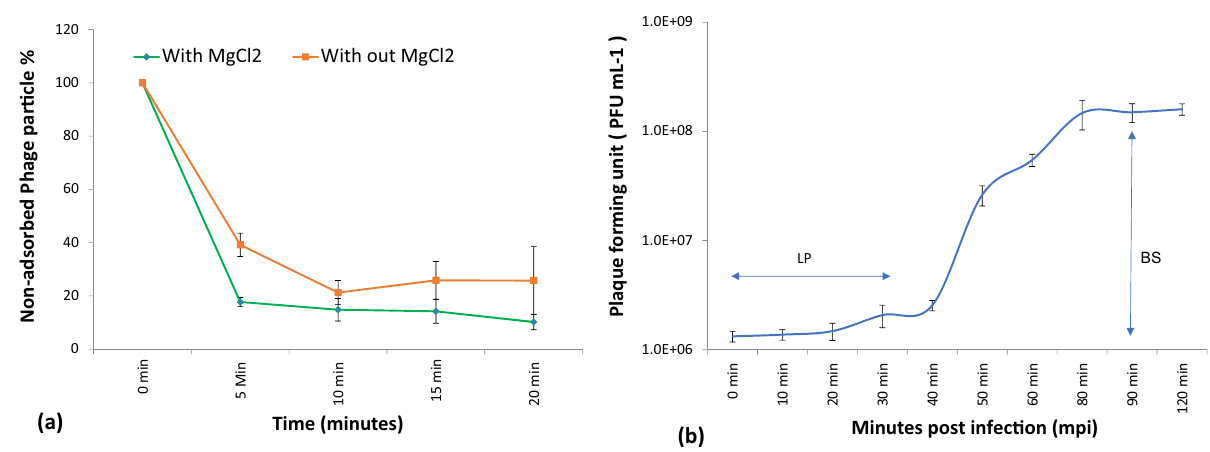
Figure 10. ( a ) Effect of magnesium ion on adsorption rate of P. aeruginosa bacteriophage (DRL-P1). ( b ) A single-step growth curve of phage DRL-P1 measured against P. aeruginosa at an MOI of 0.1. The growth curve suggests a latent phase (LP) of ~ 30 min, while a burst size (BS) of ~ 100 PFU per infected cell. The plots represent mean obtained from three independent replicate for each point and vertical whiskers represent SD. Plots were generated using the chart function incorporated in Excel program (MS Office version